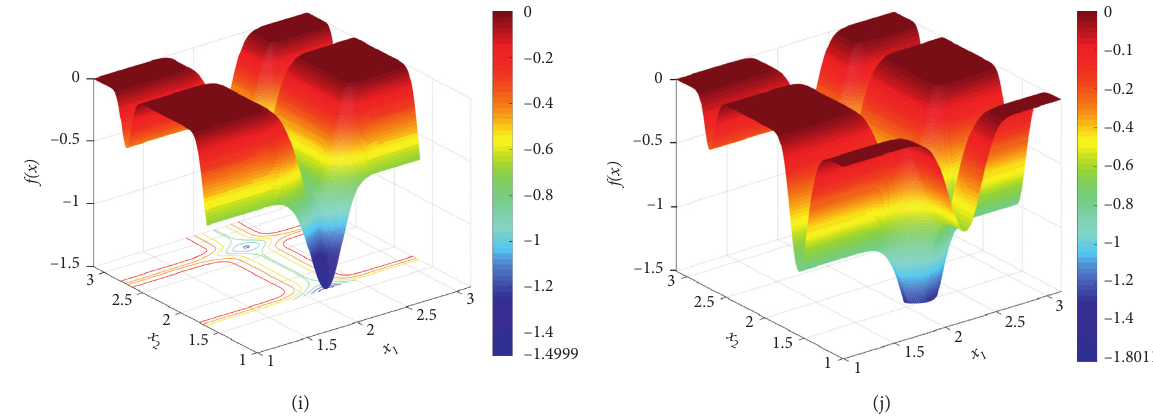
Figure 8: The values of the performance function f( x ) on the hyperboxes obtained by the following methods: (a) GHZ, (b) CES-IA, (c) d CMA-ES-IA, (d) SA-DIRECT with T 0 � 100, β =0.94 , (e) SA-DIRECT with T 0 � 150, β � 0.94, (f) SA-DIRECT with T 0 � 150, β � 0.98, (g) SA-DIRECT with T 0 � 200, β � 0.98, (h) dCMA-ES-DIRECT with d s � 8, d c � 1, (i) dCMA-ES-DIRECT with d s � 8, d c � 3, and (j) SA- fmincon.